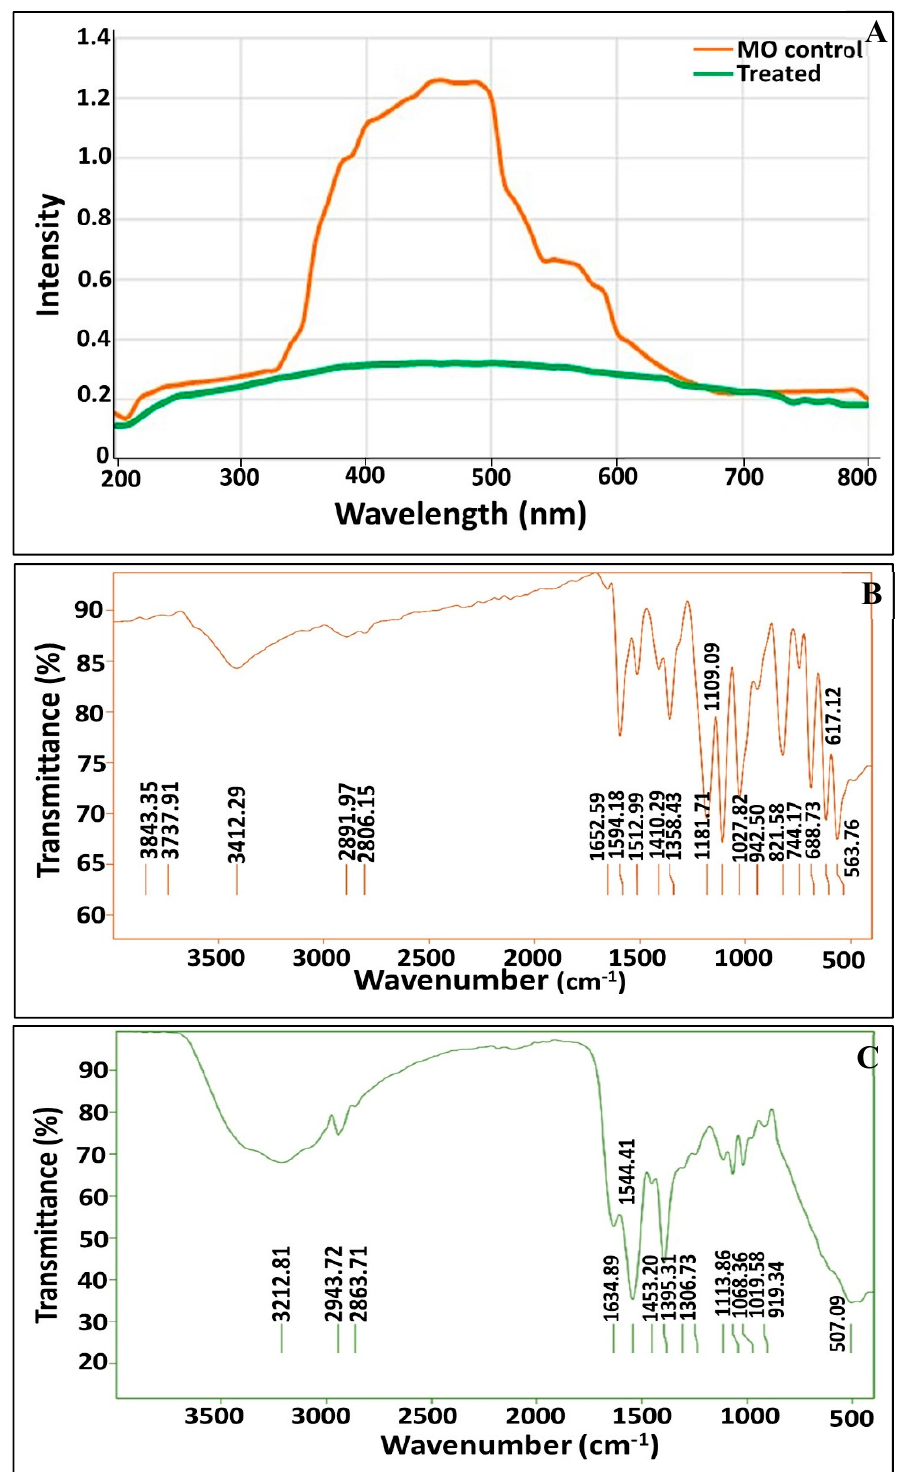
Figure 4. UV-Vis spectroscopy profile of MO before and after treatment by immobilized consortium ( A ); FTIR spectra of MO before degradation ( B ) and after degradation by immobilized consortium ( C ).